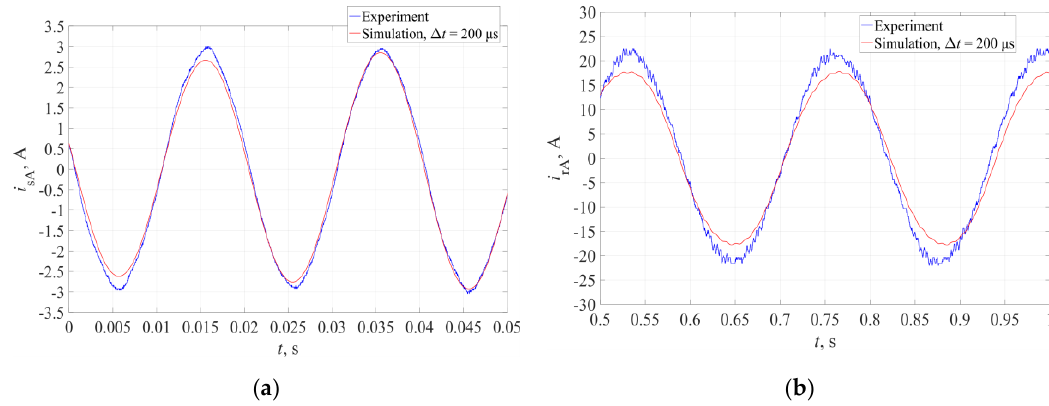
Figure 8. Waveforms of the stator current in the A phase ( a ) and rotor current in the A phase ( b ) in steady state after loading the motor with rated braking torque (blue line = experiment, and red line = simulation with Δ t = 200 s). Table 2. Nominal data and parameters of DFIM in wind turbine.